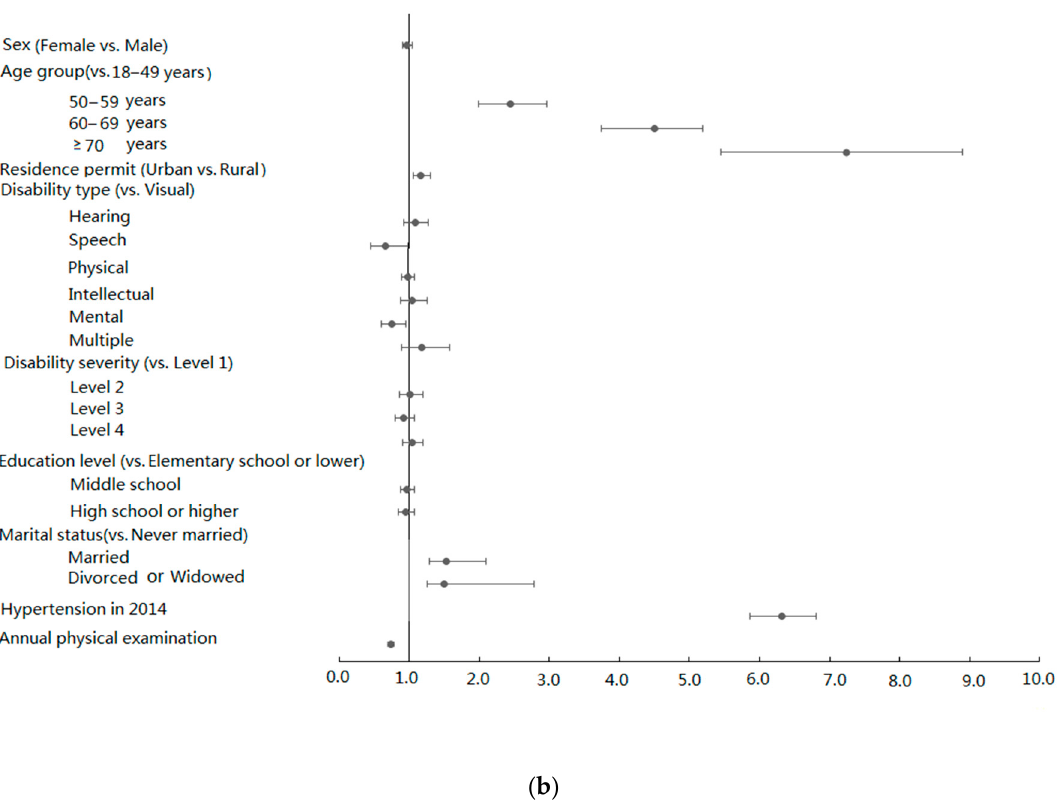
Figure 1. Analysis of risk factors for ( a ) hypertension ( b ) and hyperlipidemia.